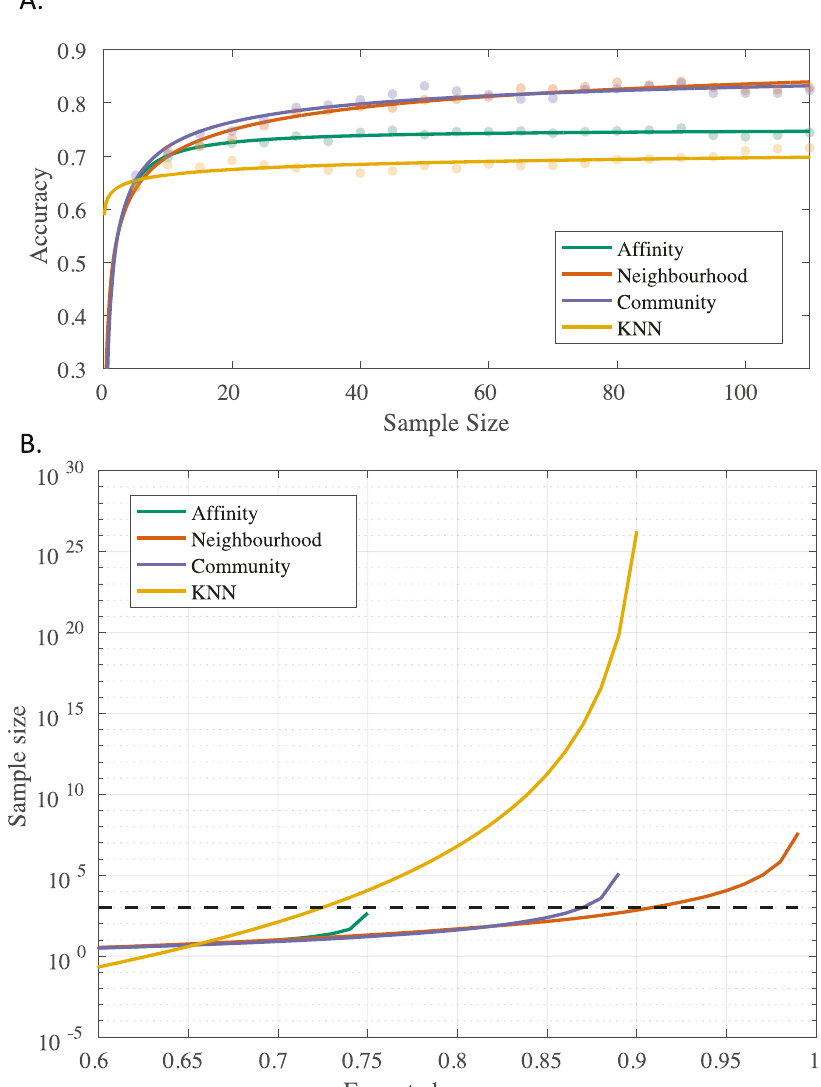
Fig. 3 Learning curves for the af fi nity scores-based classi fi ers. A Learning curves for composite multivariate af fi nity (green), common neighbourhood-based af fi nity (red), common community-based af fi nity (purple) metrics and the weighted KNN classi fi er (yellow). B Sample size as a function of expected accuracy. The common neighbourhood- and community-based metrics achieve higher accuracy compared to the composite multivariate af fi nity and weighted KNN classi fi ers. The dotted line is placed at sample size = 1000. For the current study, the common neighbourhood-based classi fi er outperforms all other classi fi ers and is expected to reach > 90% accuracy for approx. 1000